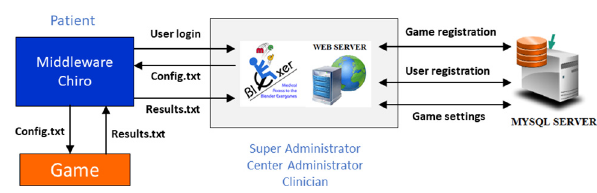
Fig. 15. Example for results obtained in different sessions performing the “Dive and eat” exercise. “Time limit” and “Time” in minutes.